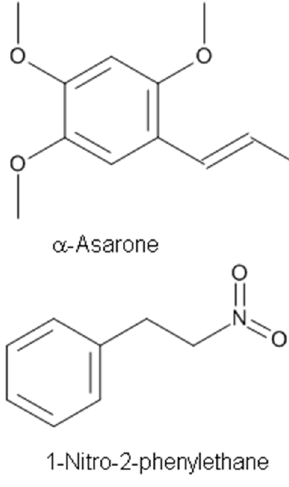
Figure 5. The non-terpene constituents with anticonvulsant and anxiolytic activities.